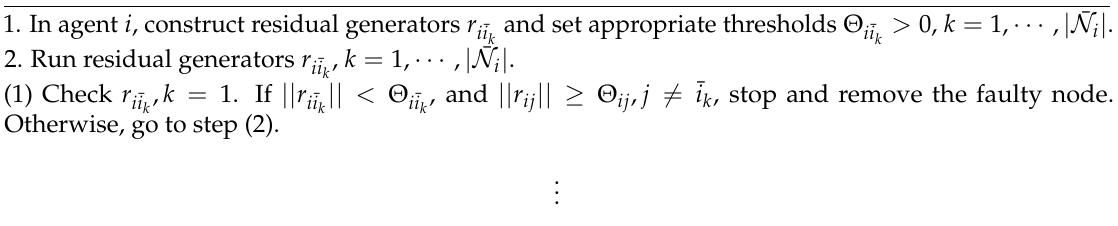
Algorithm 1 Faulty agent location